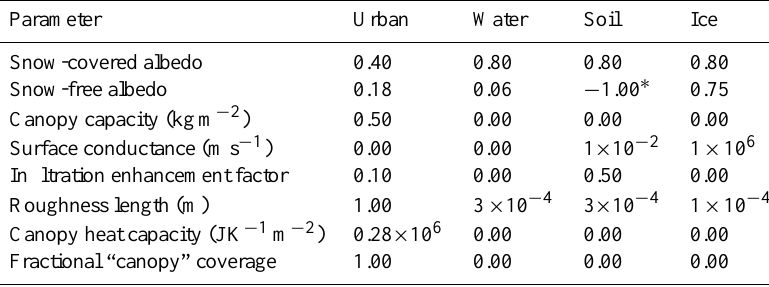
Table 6. Default parameter values required by JULES for standard non-vegetation